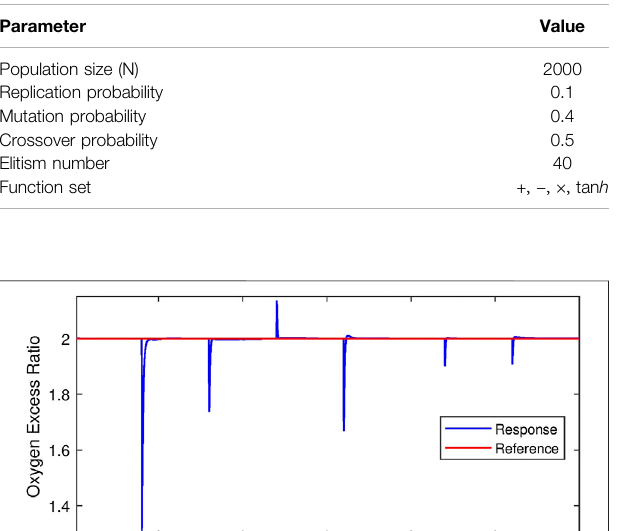
TABLE 3 | GP parameters for air fl ow control in FCS.